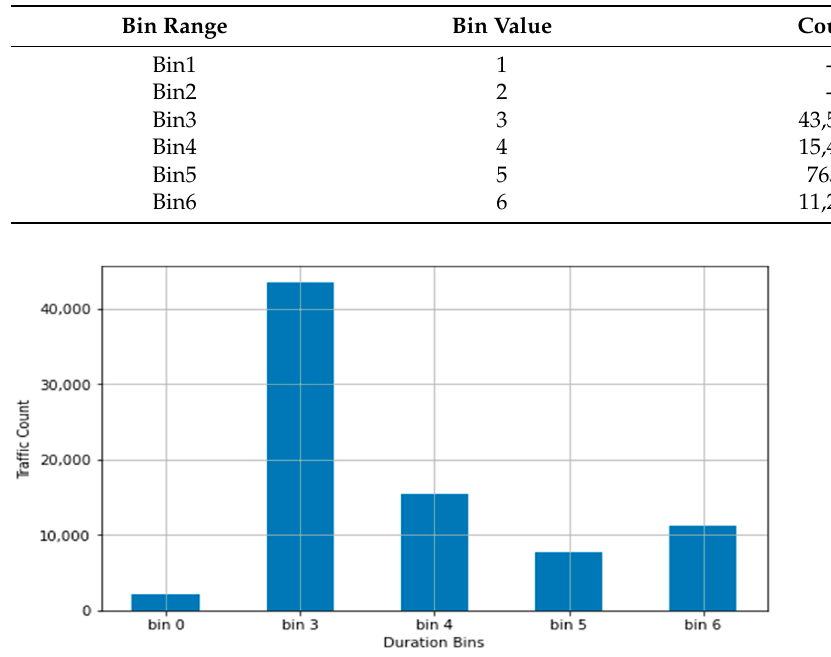
Figure 2. Initial value distribution for duration across bins.